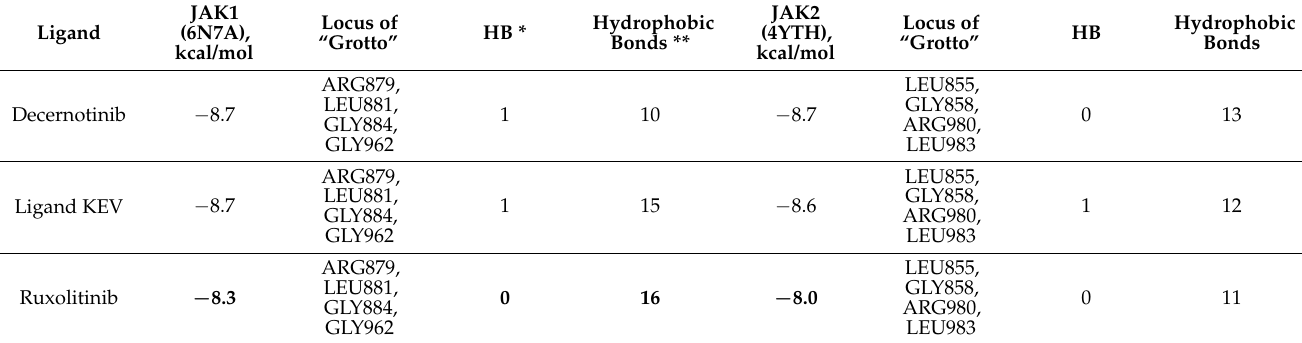
Table 2. Steric and energetic parameters of kinase binding to